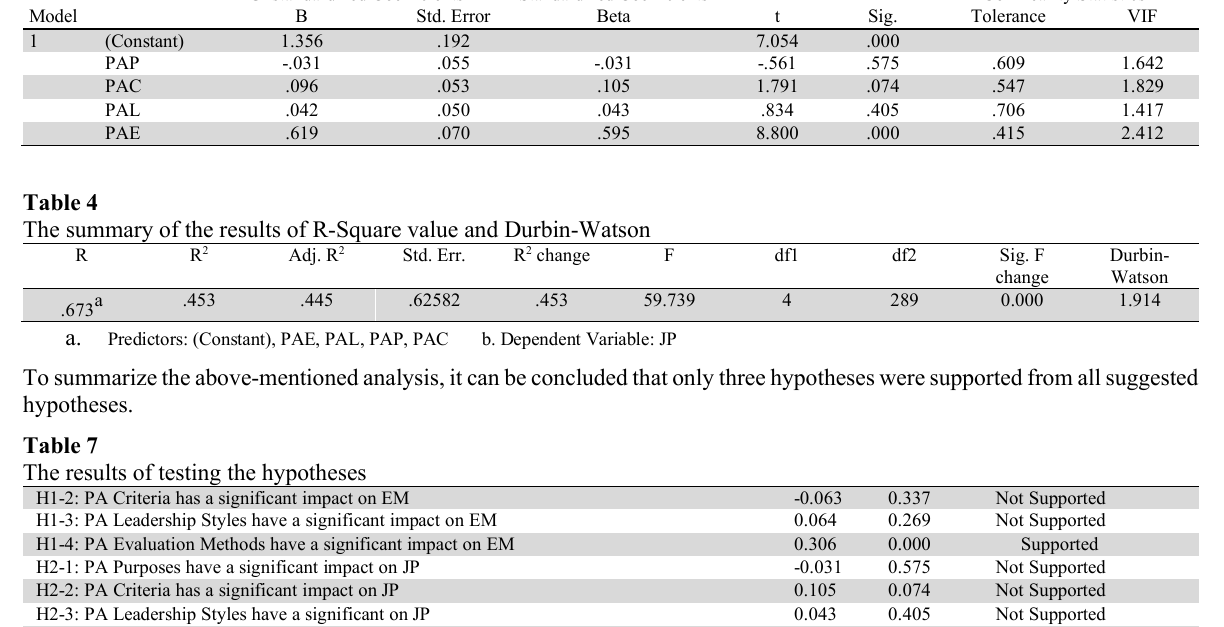
The results of regression Unstandardized Coefficients Standardized Coefficients